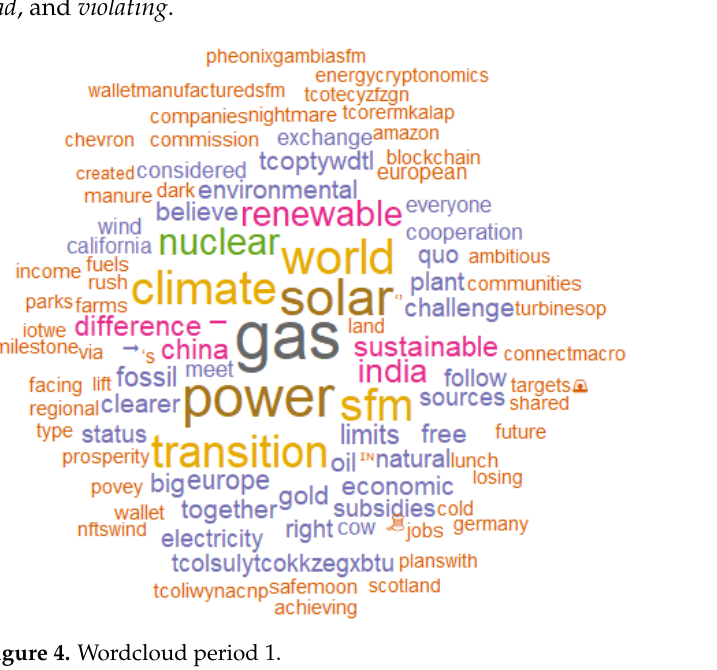
Figure 5. Wordcloud period 2.